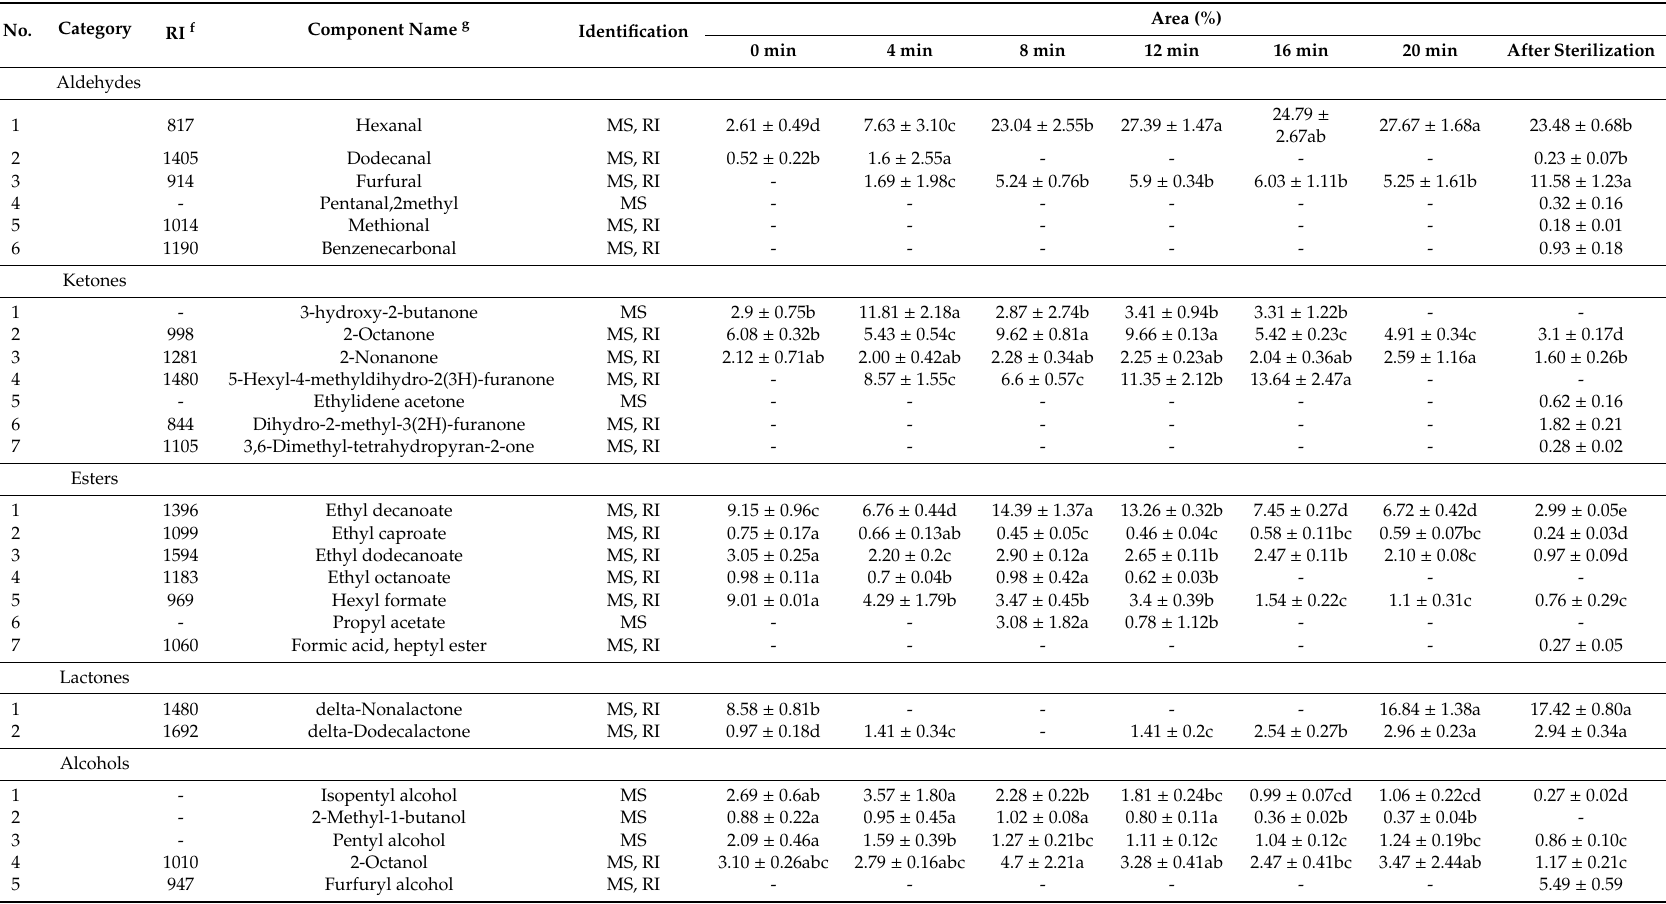
Table A1. Aroma compounds of coconut jam treated by di ff erent concentration